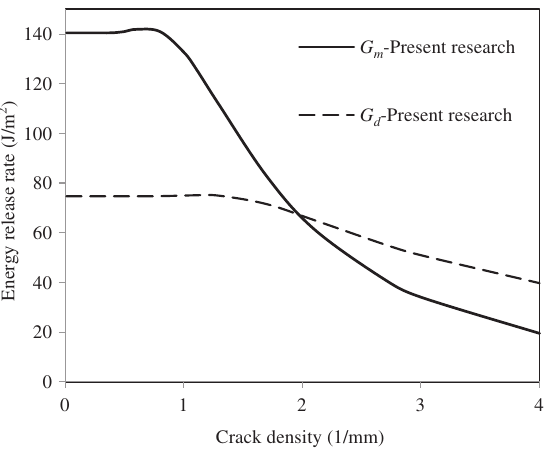
Figure 18: Crack density vs. energy release rate for [30/−30] s carbon/ Figure 21: Number of middle cracked plies vs. critical crack densities = 100 MPa, σ = 1 MPa and σ = 10 MPa. epoxy laminate under σ for distinct carbon/epoxy laminates. 1 12 2